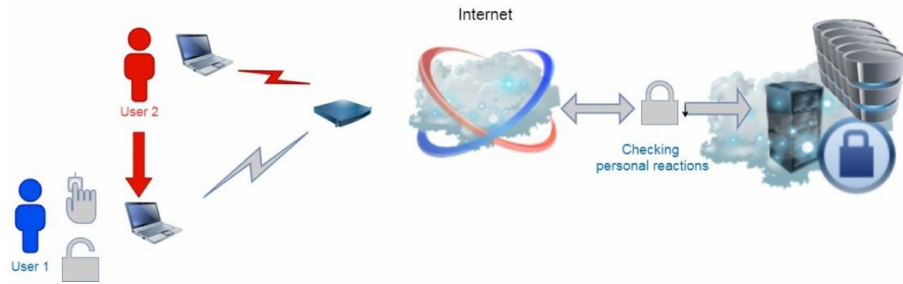
Figure 1. Example of the system with access